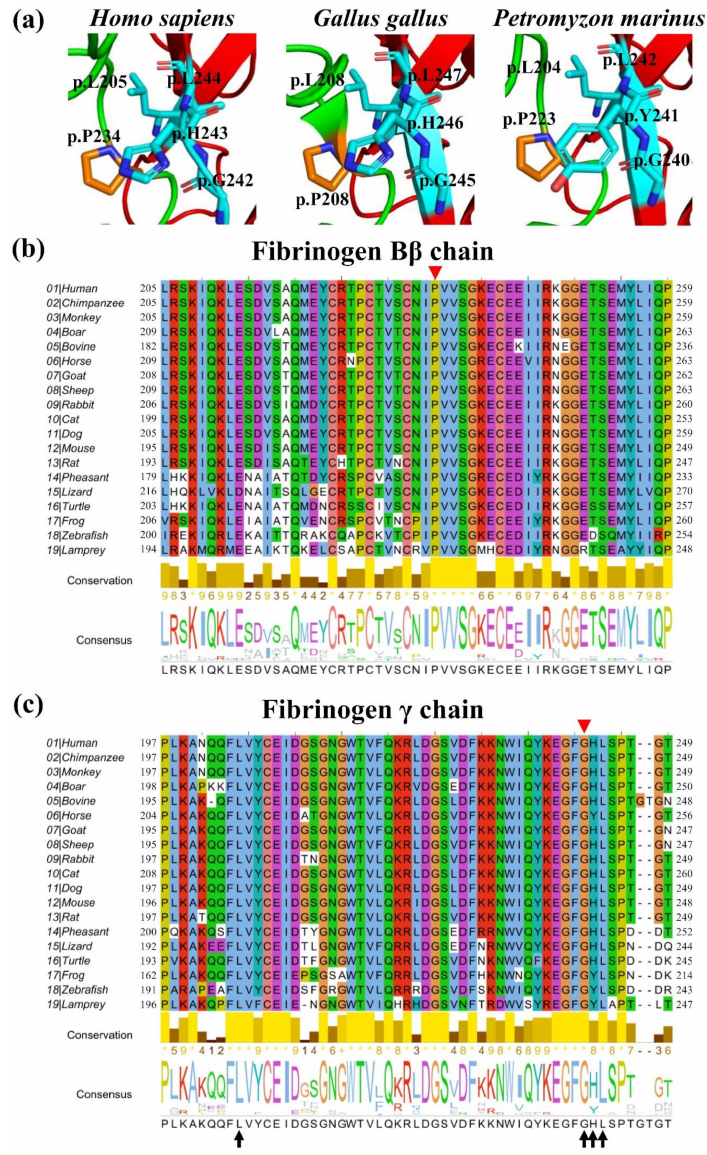
Figure 5. The structure of the B β and γ chain contact region and multiple amino acid sequence alignment. Panel ( a ) shows the B β and γ chain contact region of Homo sapiens fibrinogen (PDB ID: 2FFD), Gallus gallus fibrinogen (PDB ID: 1M1J), and Petromyzon marinus fibrinogen (PDB ID: 1LWU). The residues corresponding to the human fibrinogen B β p.P234 residue and human fibrinogen γ chain residues ( γ p.L205, γ p.G242, γ p.H243, and γ p.L244) are indicated in orange and cyan, respectively. Green and red show the B β and γ chains, respectively. Multiple amino acid sequence alignments of the B β or γ chain are shown in Panels ( b , c ), respectively. The sequence alignment was performed using the Clustal Omega program [11] and rendered with Jalview [12]. We referenced each animal fibrinogen amino acid sequence in UniProt [13]. Residues in the alignment are colored in accordance with the ClustalX [14] shading model: Color is only applied when that residue’s abundance in the column is above a residue-specific threshold, highlighting potentially important residues or patterns of conservation. The raw of conservation indicates the conservation of the physicochemical properties and shows that the lighter the yellow or the higher the value, the more conserved in the column. Asterisks ‘*’ indicate what is absolutely conserved in a column, plus ‘ + ’ indicates columns where physicochemical properties are conserved in the column with a score of 10. The raw consensus indicates the percentage of residues in the column, and the consensus sequence is shown at the bottom. The residues corresponding to mutation positions (human fibrinogen B β p.P234L and γ p.G242E) are shown with red arrowheads. Arrows in Panel ( c ) show the contact residues with the human fibrinogen B β p.P234